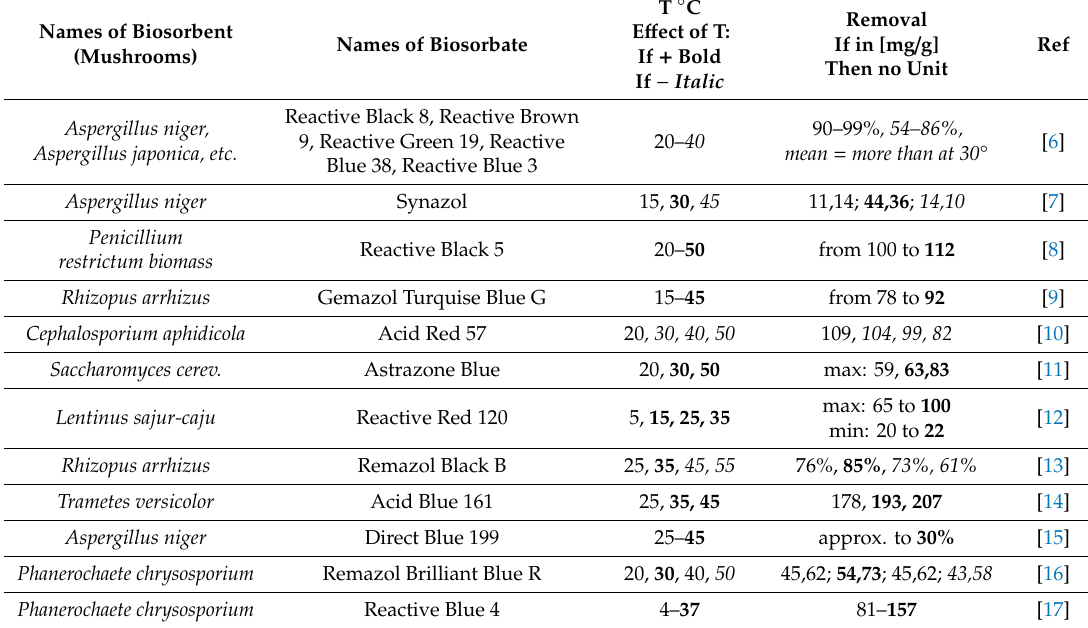
Table 1. Data and parameters describing the influence of temperature (T) on biosorption (Bios) of dyes from aqueous solutions on fungal biomass (its Latin name is in column